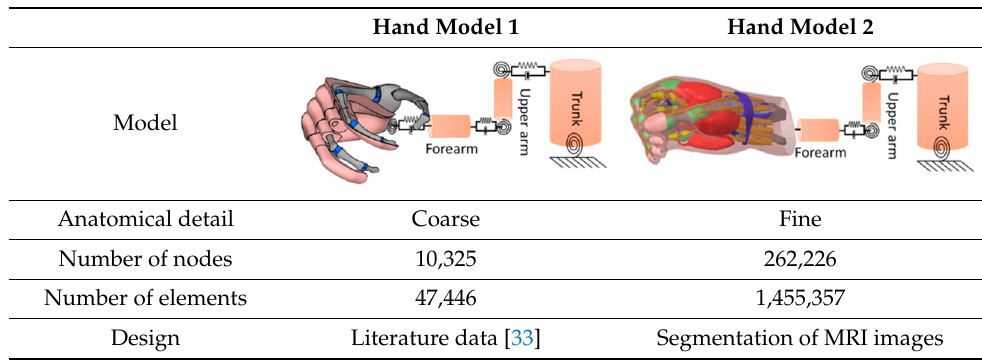
Table 1. The two finite element models developed.